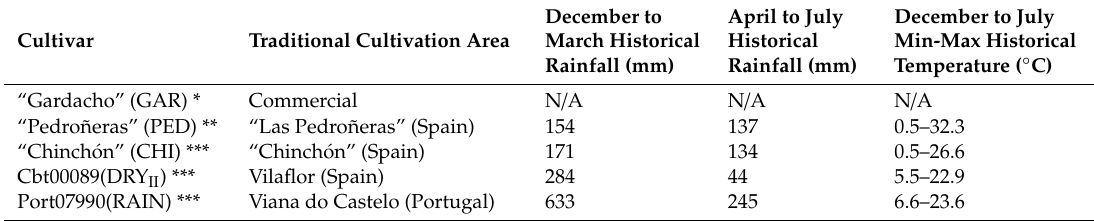
Table 1. Cultivars and long-term rainfall, and minimum and maximum temperatures at their traditional cultivation area. Climate date from 1902 to 2012 [52].